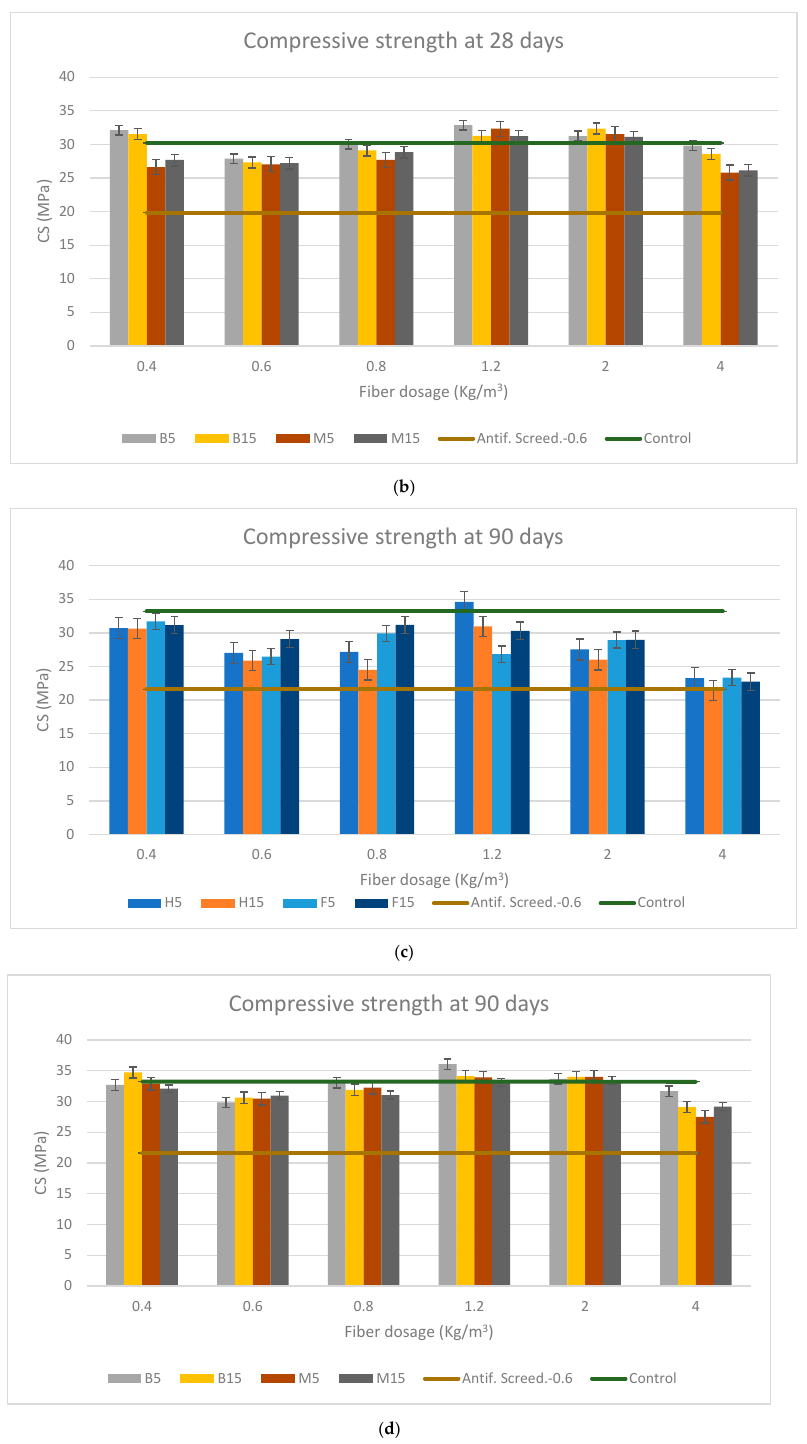
Figure 10. ( a ) Compressive strength at 28 days for soft fibers. ( b ) Compressive strength at 28 days for rigid fibers. ( c ) Compressive strength at 90 days for soft fibers. ( d ) Compressive strength at 90 days for rigid fibers. Table 9. ( a ) Flexural strength (FS) at 28 days (MPa) mean value measured on three specimens for each mortar mix. ( b ) Flexural strength at 90 days (MPa) mean value measured on three specimens for each mortar mix. AS: antifissuration screed mortar (0.6 kg/m 3 of fiber dosage)—Flexural strength range respect AS; Flexural strength AS: 5.92 MPa.